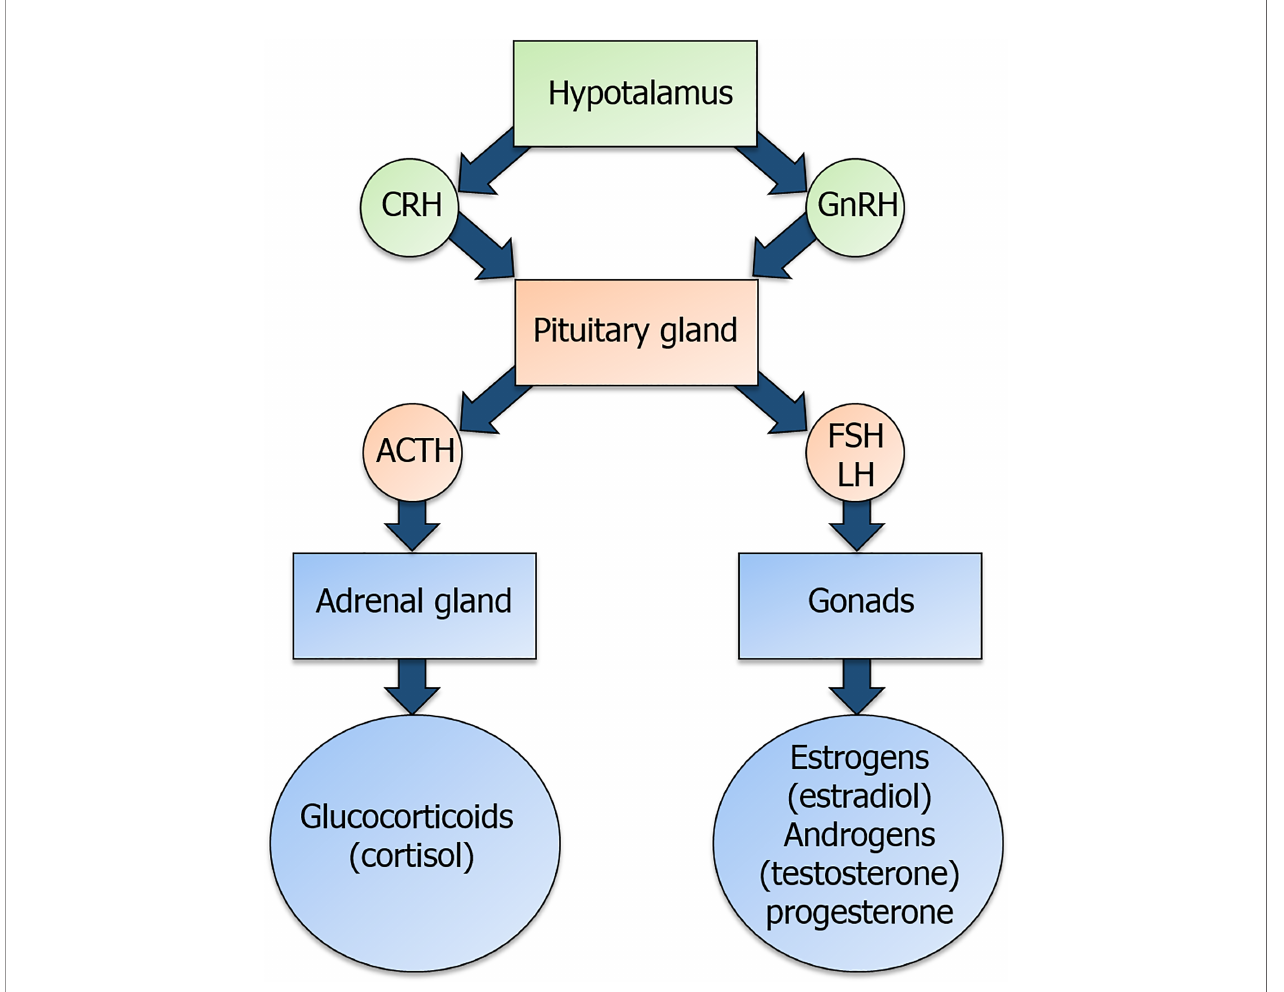
FIGURE 1 | Overview of the hypothalamic-pituitary-adrenal (HPA) axis and of the hypothalamic-pituitary-gonadal (HPG) axis. Corticotropin-releasing hormone (CRH) and gonadotropin-releasing hormone (GnRH) are released by the hypothalamus and act on their receptors in the pituitary gland. In detail, CRH binding to its receptor triggers the production of the adrenocorticotropic-hormone (ACTH), while GnRH binding to its receptor triggers the production of the gonadotropins follicle- stimulating hormone (FSH) and luteinizing hormone (LH). ACTH and gonadotropins are released in the bloodstream and act on the adrenal gland and the gonads, respectively, to induce the secretion of glucocorticoids and sex